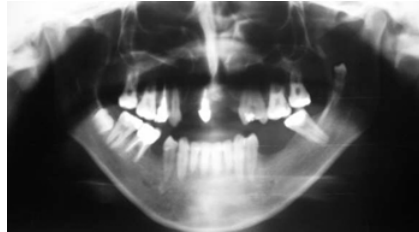
FIGURE 9- Patient at the age of 30: mandibular left 2nd premolar located in mandibular notch area, without significant alteration